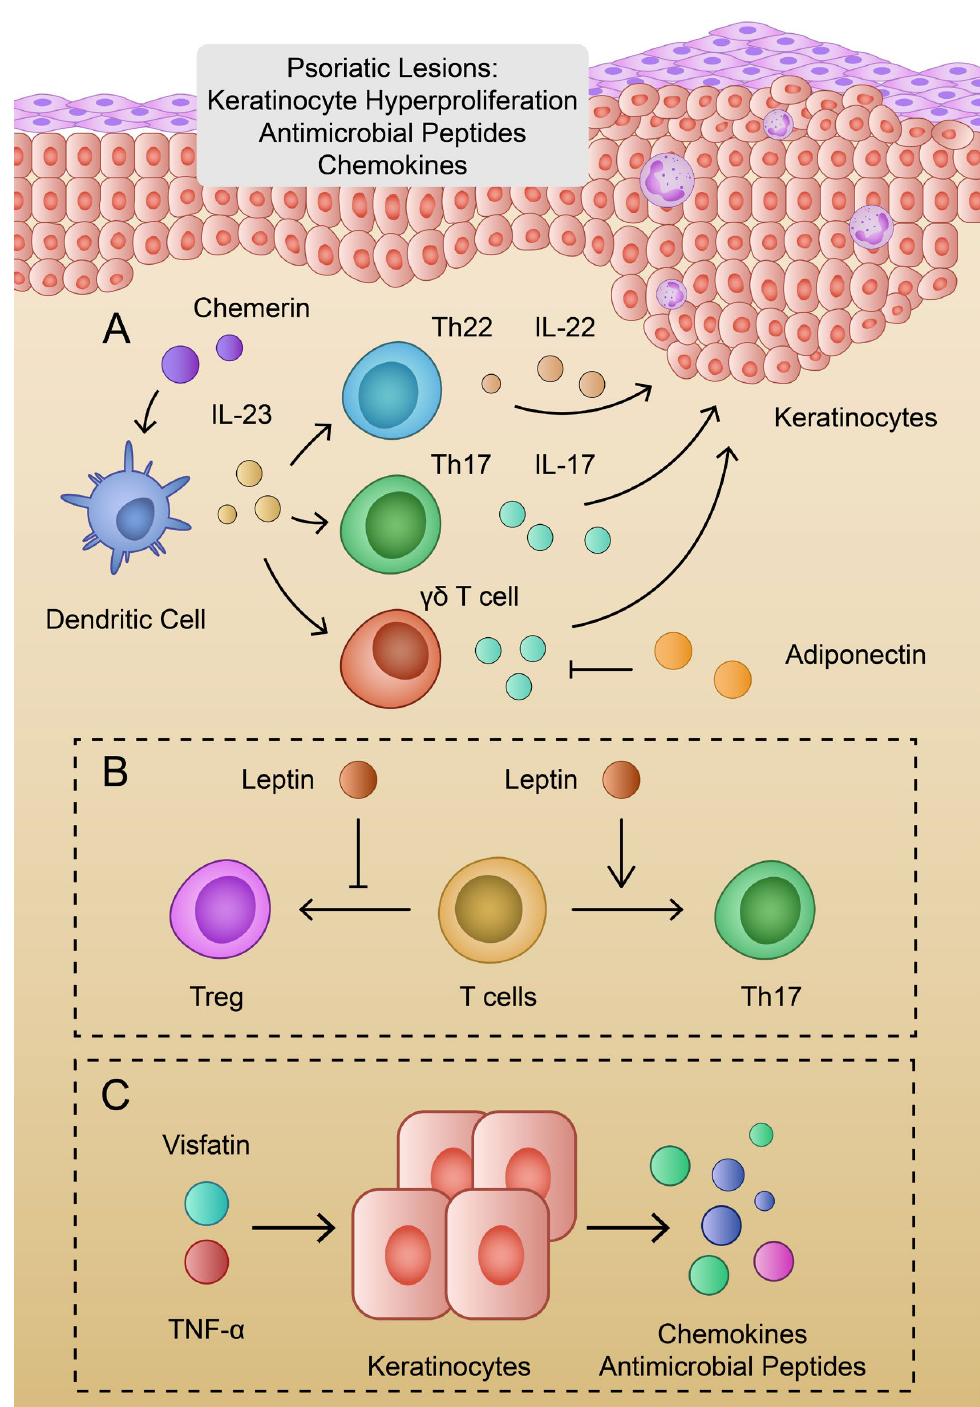
Figure 2. ( A ): Schematic representation of the pathogenesis of psoriasis and the roles of chemerin and adiponectin; ( B ): Impact of leptin on T cell variants; ( C ): Visfatin and TNF- α promote production of chemokines and antimicrobial peptides.